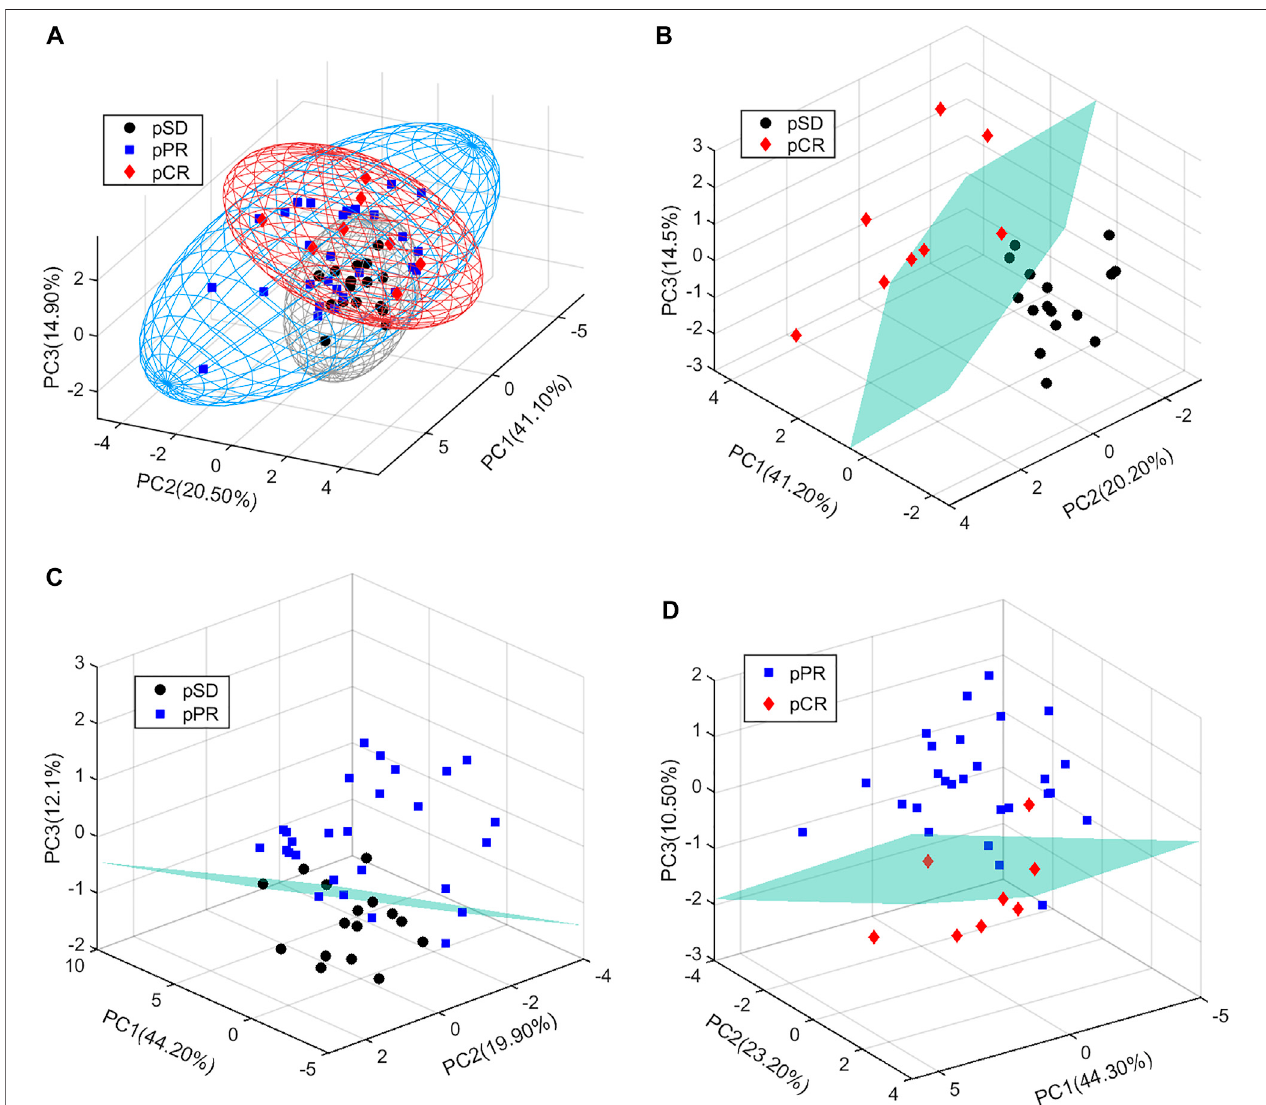
FIGURE 2 | PCA score plots of the relative concentration of metabolites ’ data from three groups of TNBC patients: (A) all patients; (B) pSD patients vs. pCR patients; (C) pSD patients vs. pPR patients; (D) pPR patients vs. pCR patients.